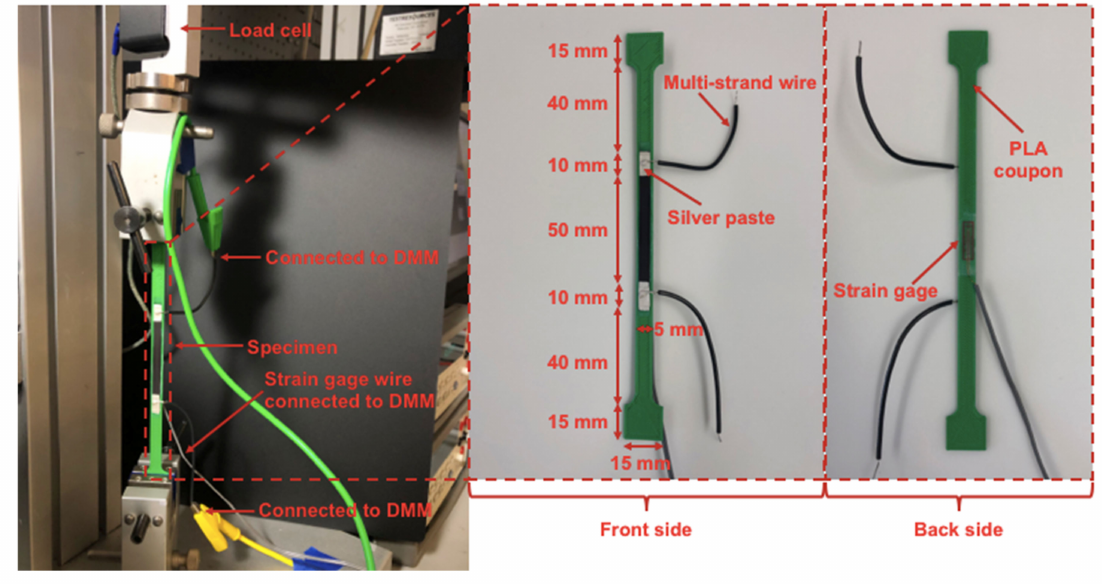
Figure 2. Nanocomposite paint was spray-coated onto a TPU substrate and then affixed onto a PLA test coupon. A strain gage was mounted onto the backside of the coupon and subjected to electromechanical